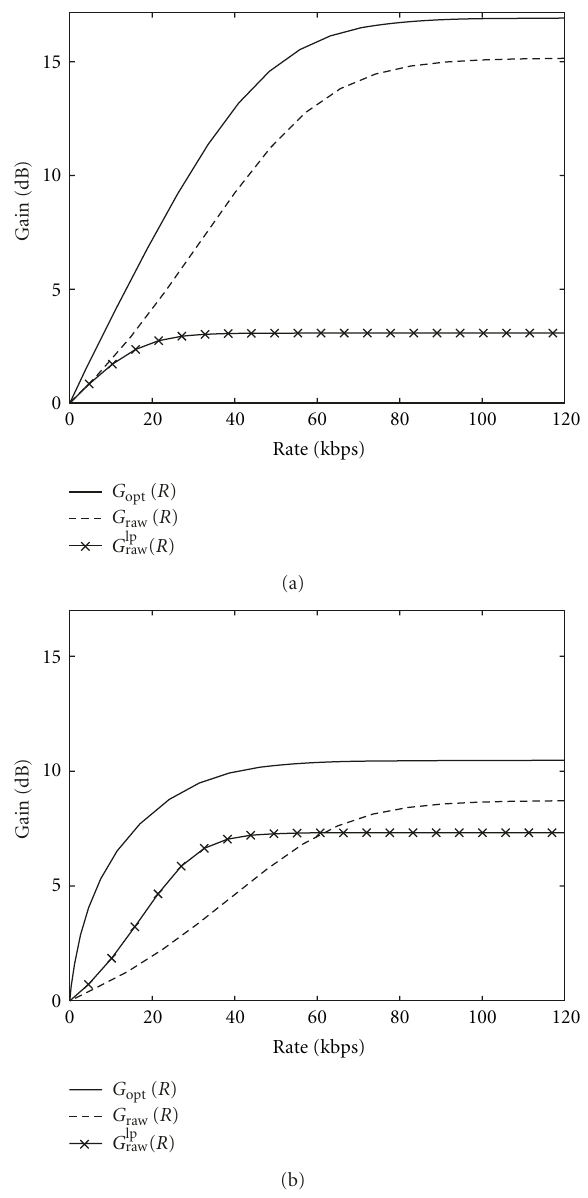
Figure 8: Performance gain for the di ff erent schemes when a desired signal is observed in the presence of uncorrelated noise at 20 dB SNR, K = 2, and only the low-frequency portion is transmitted (below 4kHz). (a) Interfering source at 0dB SIR located at 30 ◦ . (b) Interfering source at 0 dB SIR located at 120 ◦